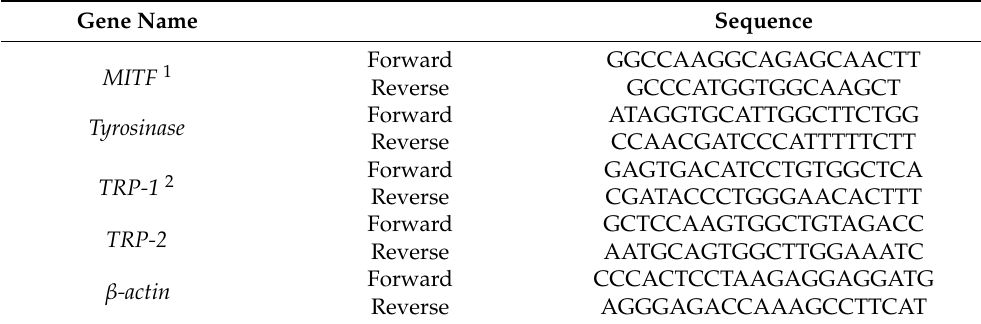
Table 1. List of primers used for the RT-PCR